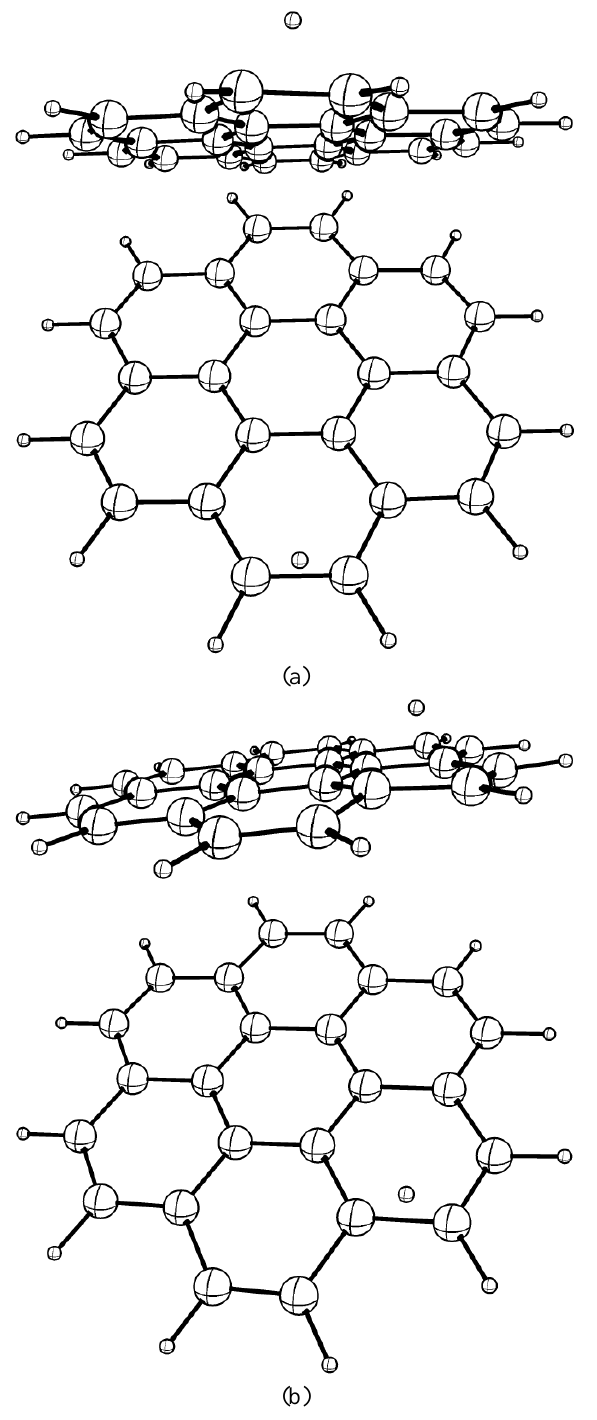
Fig. 3. The transition state of edge migration, a and b for radicals (side and top view)